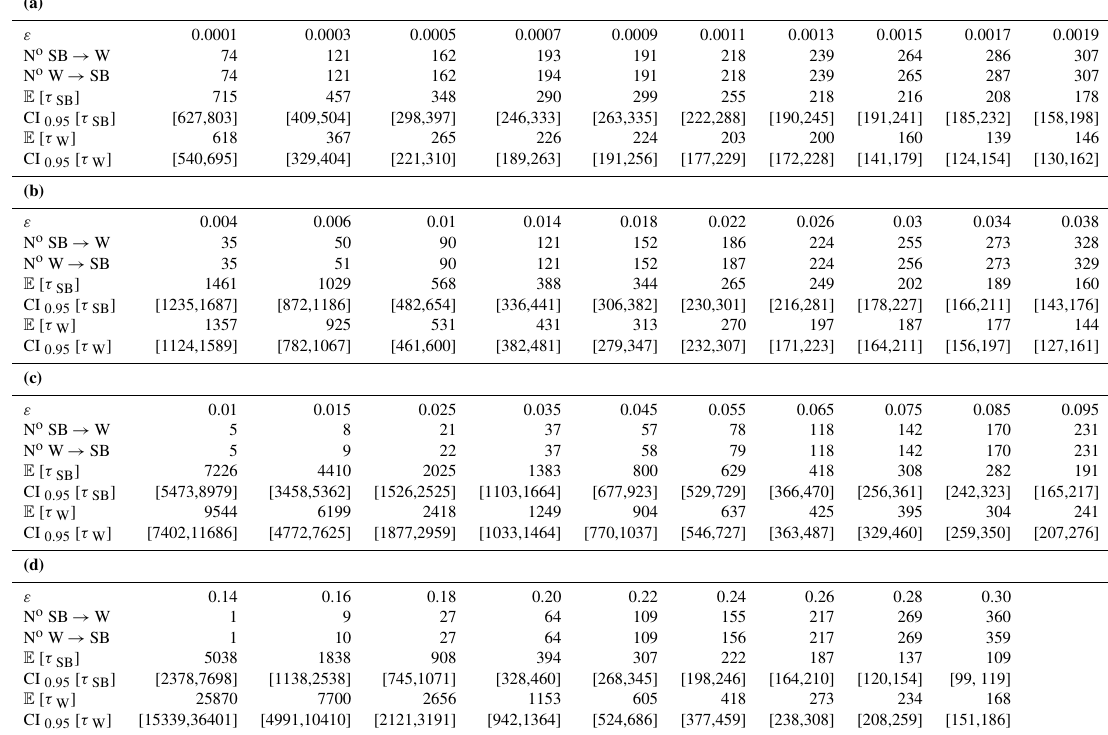
Table D1. Estimates and 95% confidence intervals for the mean escape time τ from the W state and from the SB state, for Lévy noise with (a) α = 0 . 5, (b) α = 1 . 0, (c) α = 1 . 5, and (d) Gaussian noise. N o indicates the average number of transitions occurring in 10 5 years of temporal